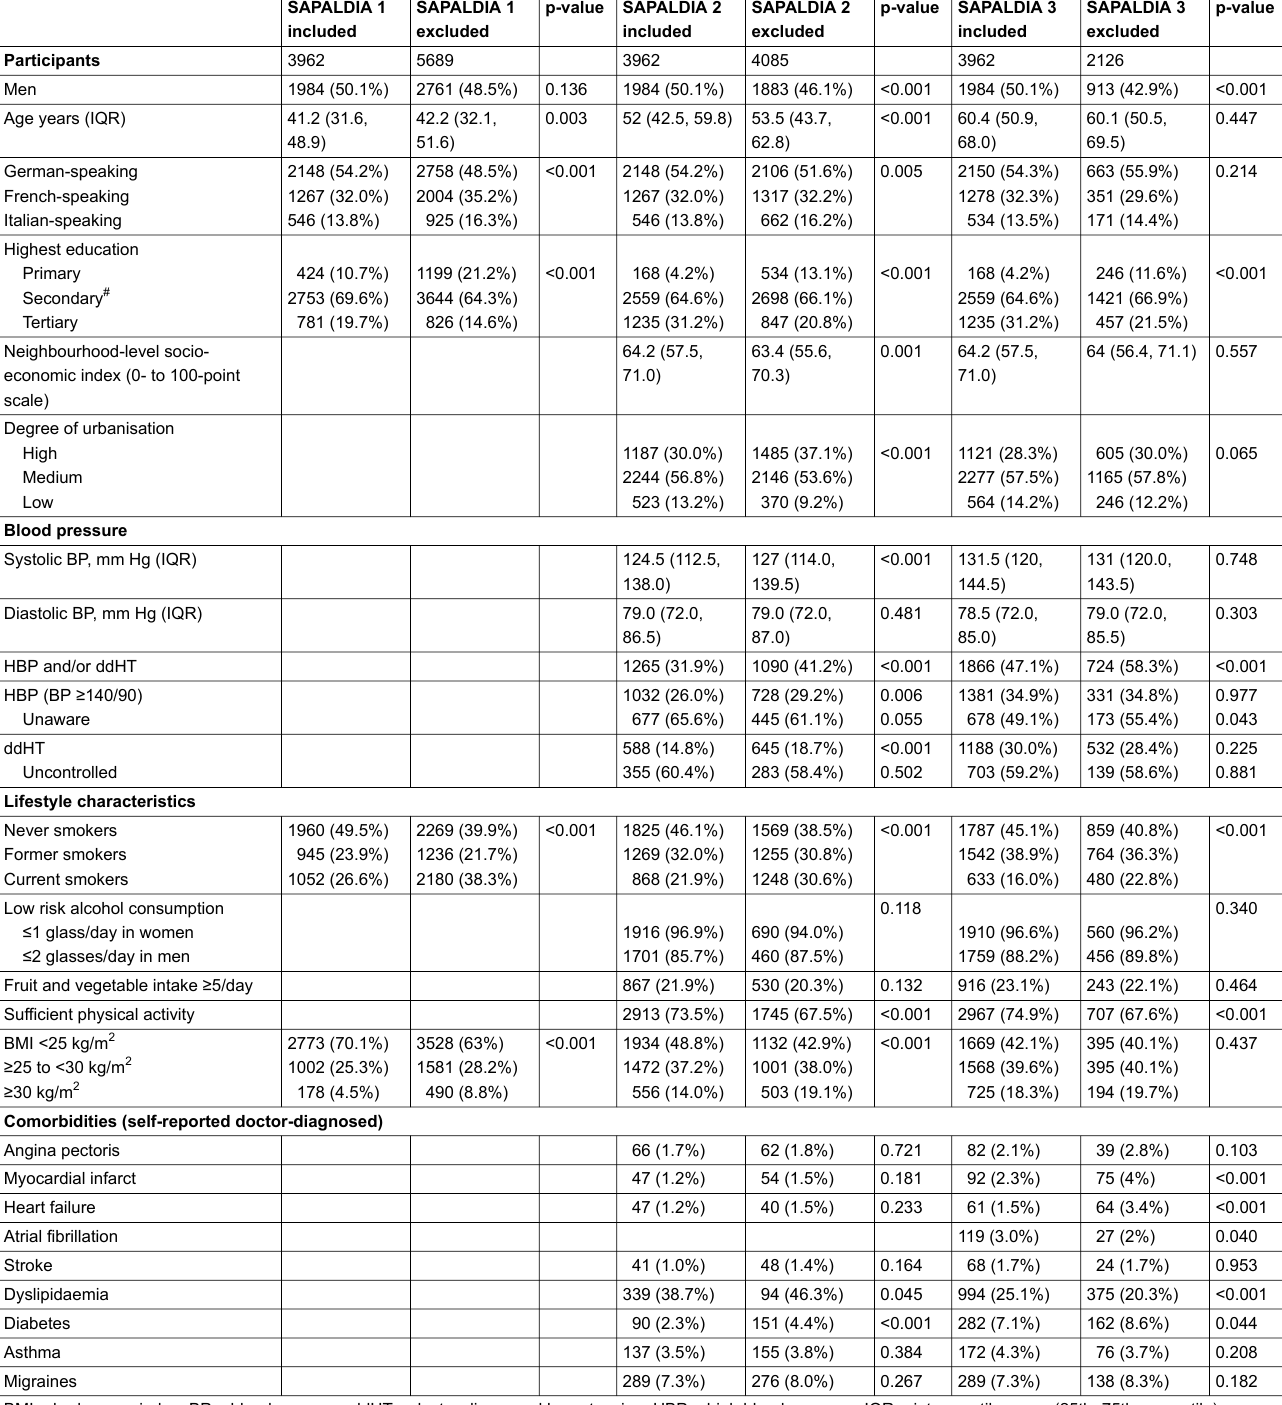
Table S1: Characteristics of included and excluded participants at baseline, and first and second follow